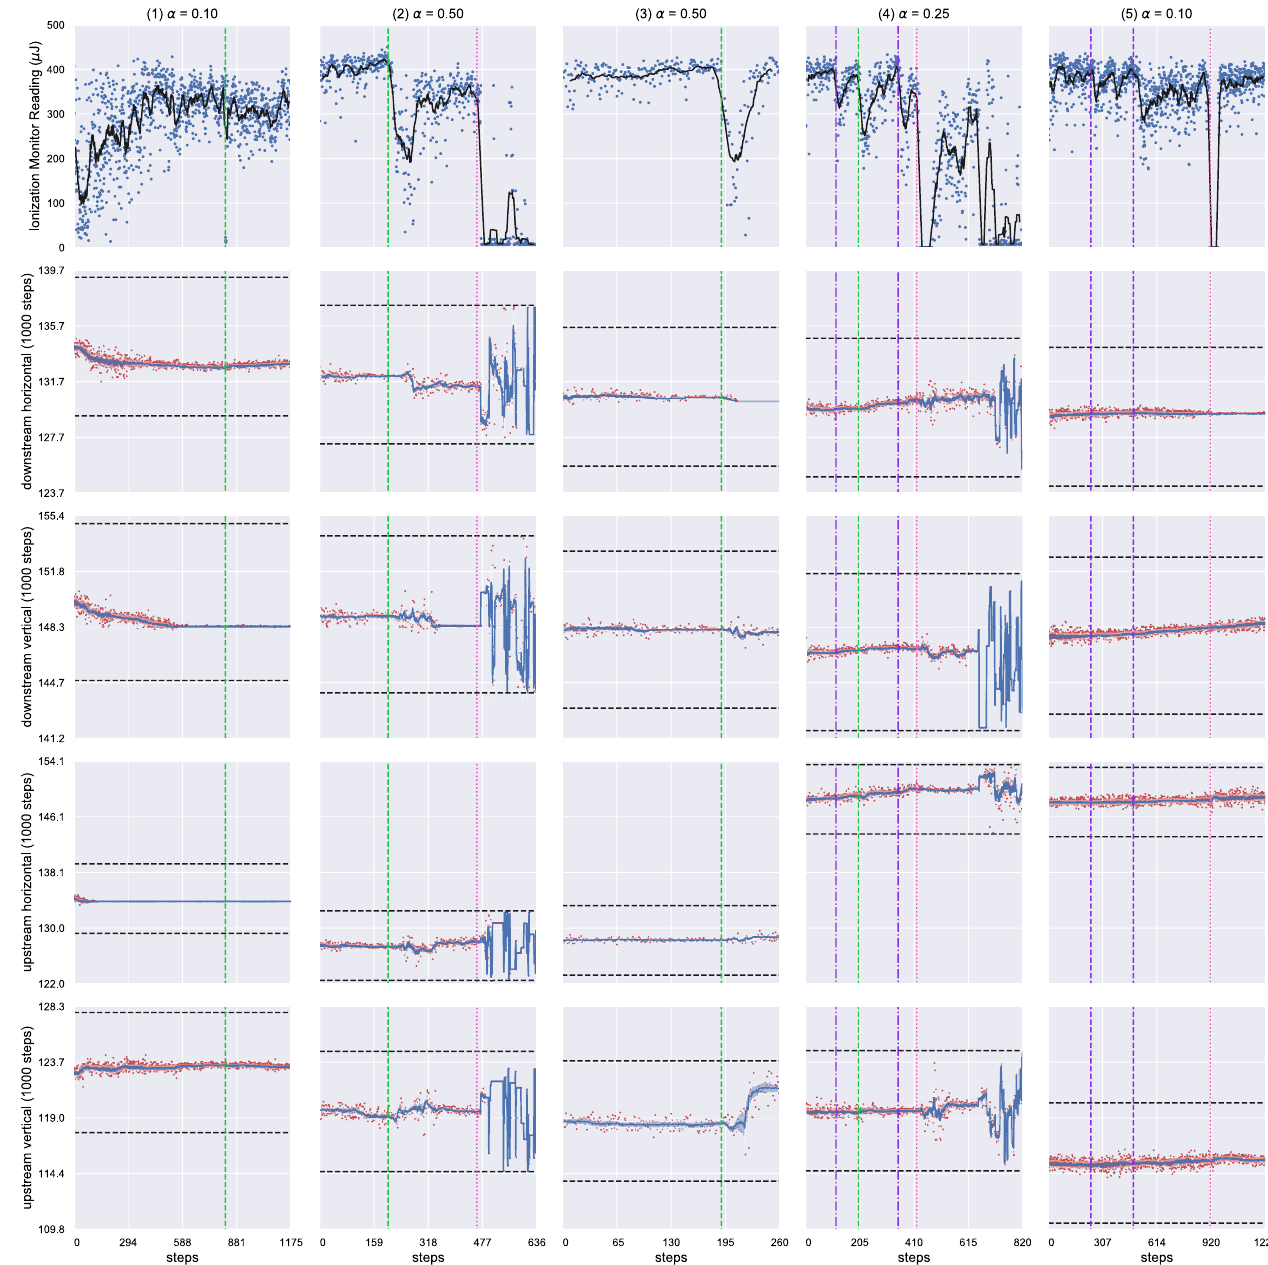
FIG. 9. Maintenance of a single stage HGHG FEL using policy gradient methods. The agent controls the pointing of the seed laser through the modulator undulator where it interacts with the electron beam. The target variable to maximize is the FEL energy, as measured by an ionization monitor. Each column represents a different run and the learning rate for each run is shown at the top of each column. The first row is the FEL pulse energy. The remaining rows are the setting (in steps) of the four piezo motors that control the seed laser pointing. The vertical lines represent changes made to the FEL during the run: green, dashed lines represent the seed laser being moved horizontally by a human operator; purple, dash-dot lines represent the seed laser being moved vertically by a human operator; and the magenta dotted lines represent a fault in the accelerator that resulted in the electron beam being shut off by turning off the cathode laser. The black dashed horizontal lines show the allowed range of operation for each device and each